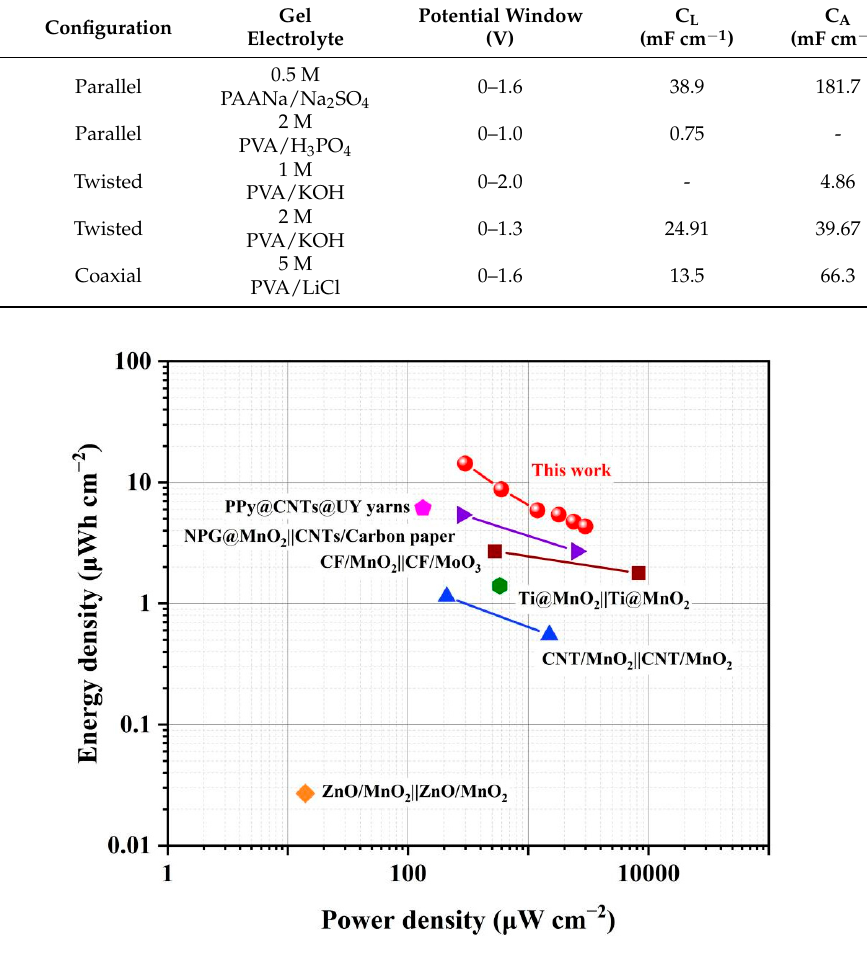
Figure 11. Ragone plot of the WASC compared with similar reported works.